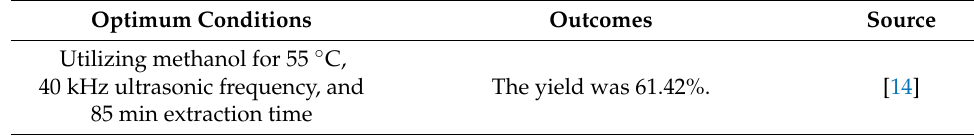
Table 3. The optimal parameters and outcomes in orange peel extraction by